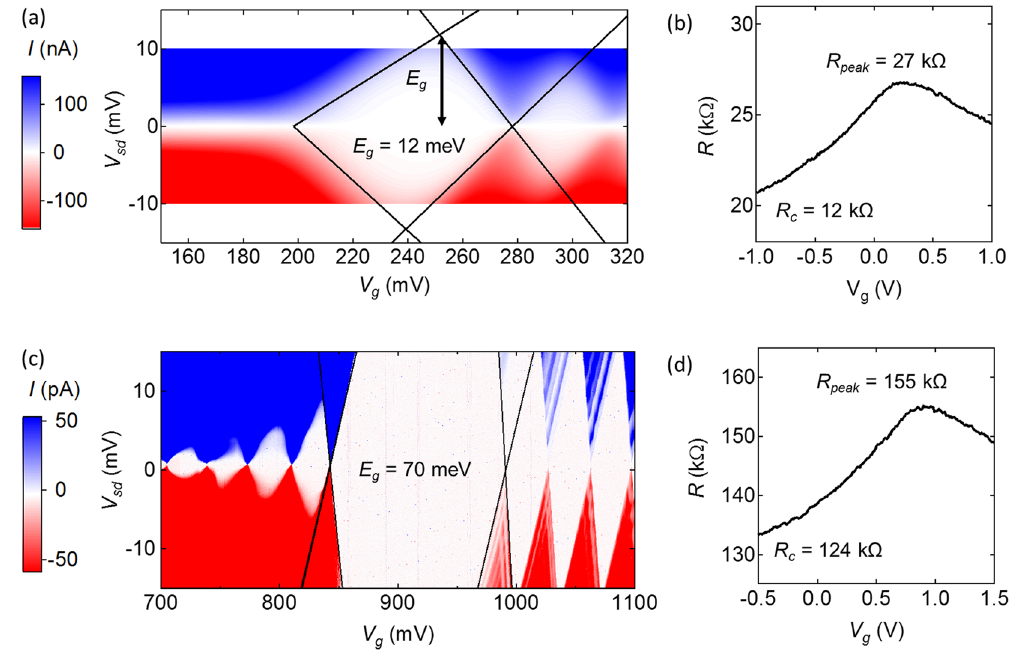
Figure 4. Low-temperature and room-temperature transport for two narrow-gap devices. ( a ) and ( c ) show Coulomb blockade spectroscopy taken at T = 2 K. The lines follow the edges of the 0 th diamond and are extrapolated to determine the band gap. ( b ) and ( d ) show room temperature resistance as a function of gate voltage.